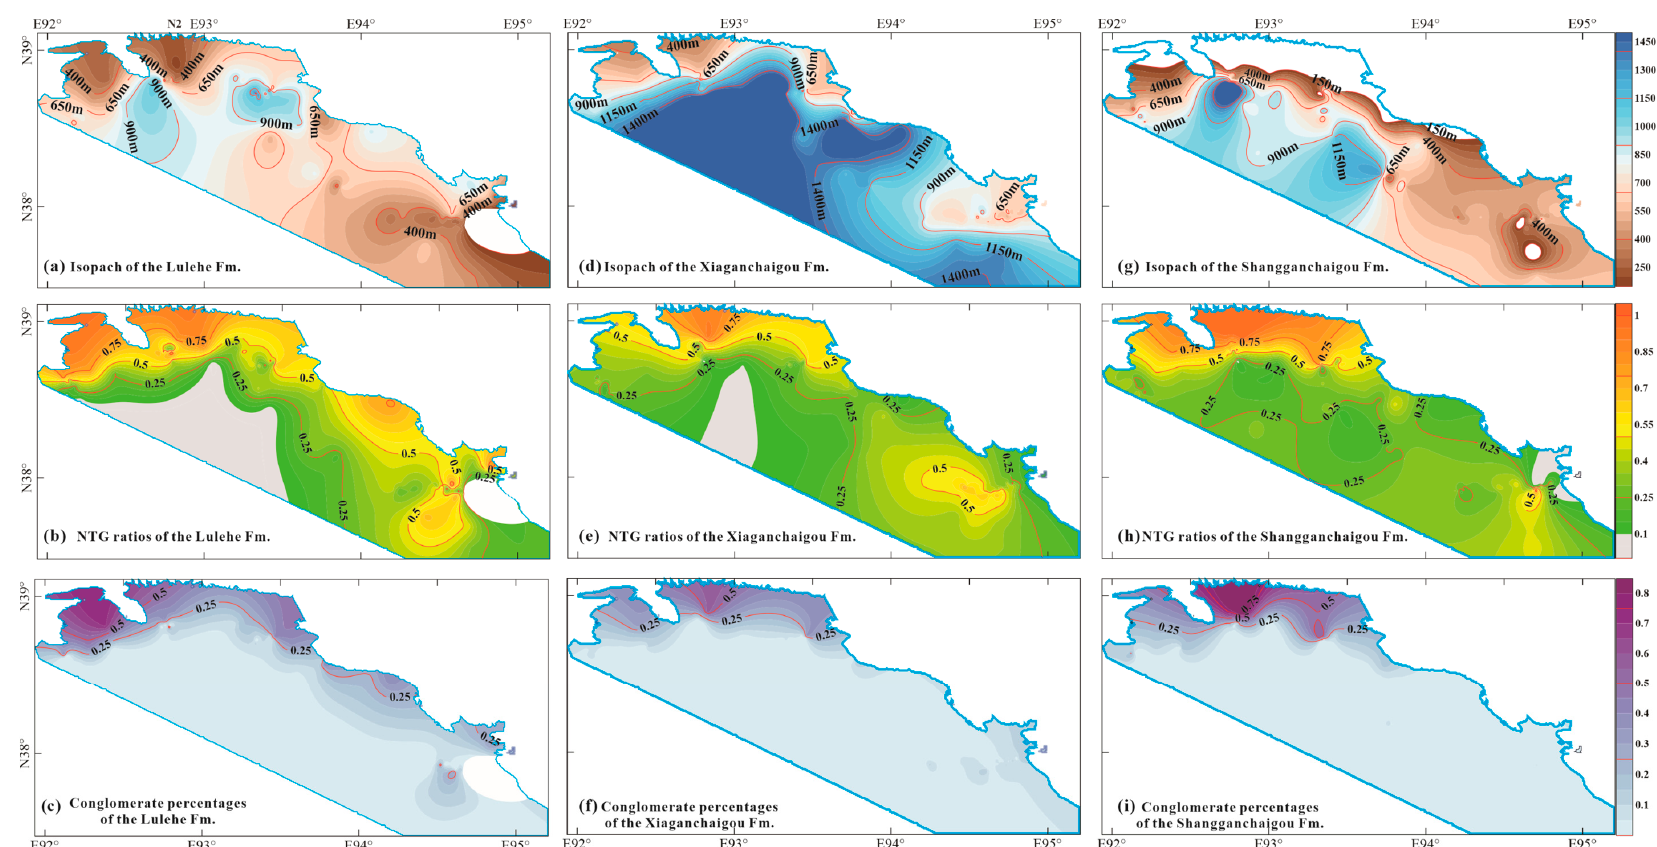
Figure 3. The plane distribution of stratigraphic thicknesses, NTG ratios and conglomerate percentages of the Paleogene strata. White area in study area represents area missing stratum. ( a ) Isopach of the Lulehe Fm. ( b ) NTG ratios of the Lulehe Fm. ( c ) Conglomerate percentages of the Lulehe Fm. ( d ) Isopach of the Xiaganchaigou Fm. ( e ) NTG ratios of the Xiaganchaigou Fm. ( f ) Conglomerate percentages of the Xiaganchaigou Fm. ( g ) Isopach of the Shangganchaigou Fm. ( h ) NTG ratios of the Shangganchaigou Fm. ( i ) Conglomerate percentages of the Shangganchaigou Fm.